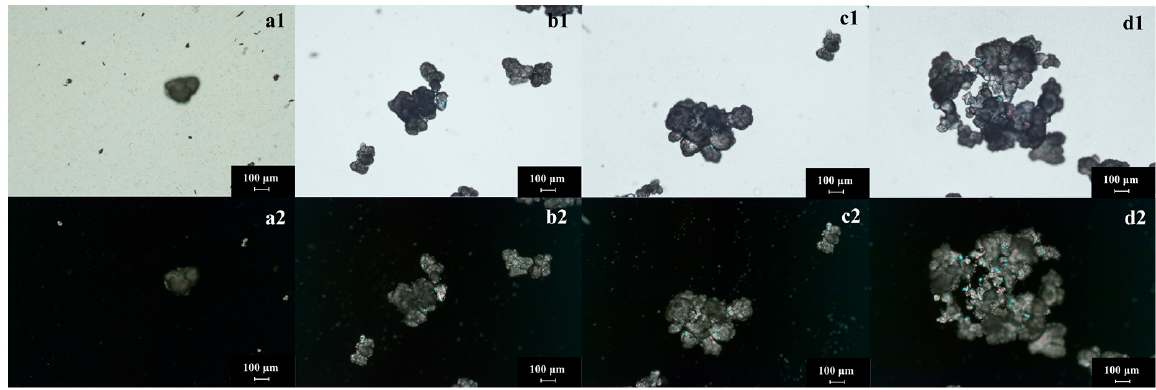
Figure 5. Image of the process of spontaneous nucleation to produce amorphous products.